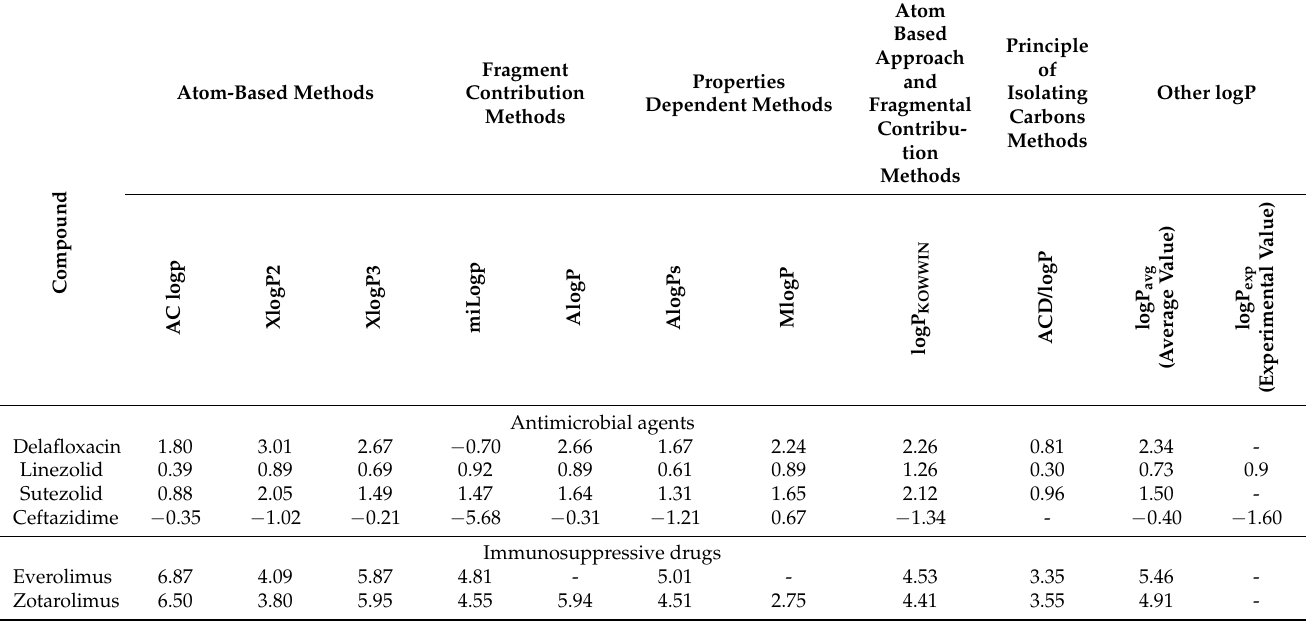
Table 2. Partition coefficients (logP) of studied